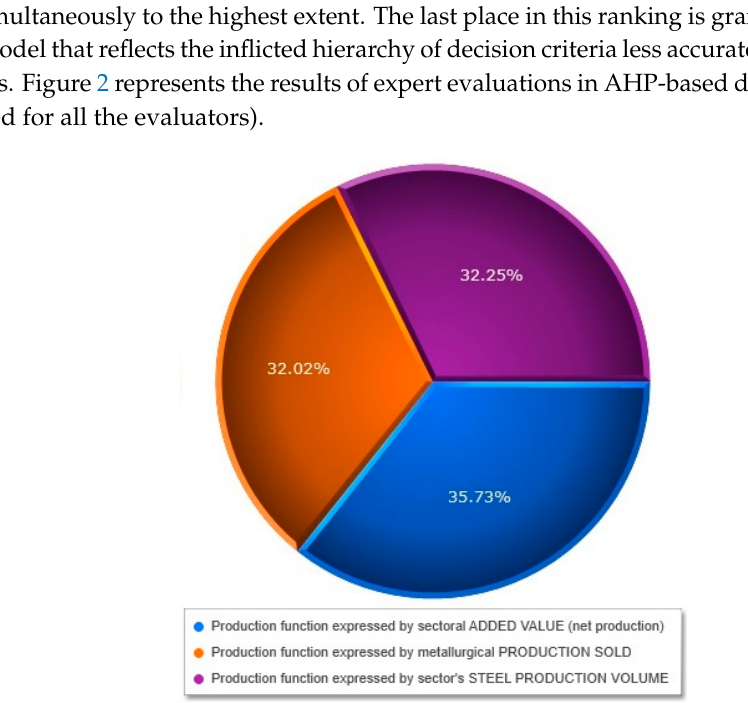
Figure 2. Aggregated results of experts’ rankings in frames of Analytic Hierarchy Process (AHP) decision alternatives. Source: own elaboration based on research results.